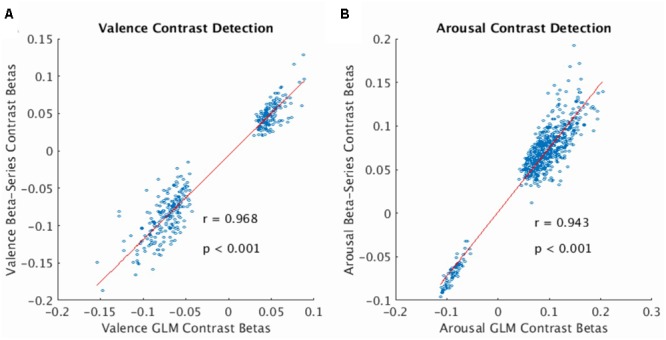
Correlation of voxelwise statistics across univariate and multivariate representations of the BOLD fMRI signal. (A) Correlation between mean GLM Contrast Betas and mean Beta-Series Contrast Betas computed for the valence dimension of the stimulus (average calculated over participants). Strong correlation indicates that Beta-Series captures comparable activation information to GLM. (B) Same as (A) for the arousal dimension of the stimulus. In both plots, red line represents the linear robust regression fit of the data. Comparison voxels were chosen as those voxels simultaneously satisfying the following constraints: group-level GLM contrast betas’ one-sample t-statistic having |t-score| > 3.63, presence in all 32 folds of the LOOCV of the gray-matter mask (valence voxels = 380; arousal voxels = 628).